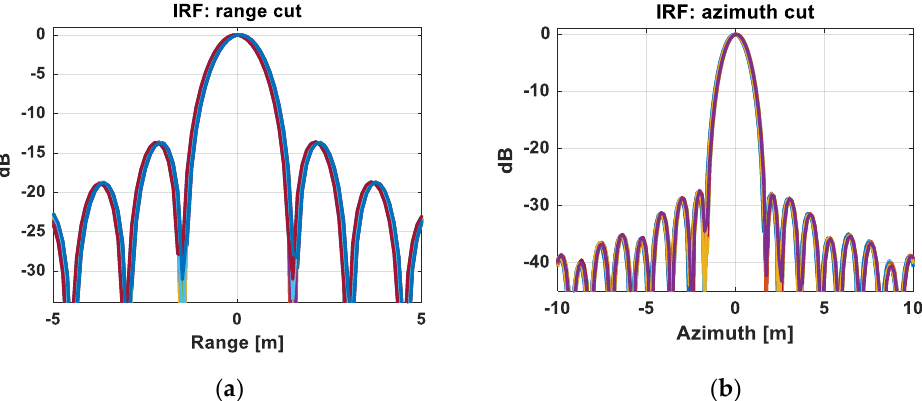
Figure 10. Zoom of the multichannel recombined focused impulse response of the nine point-targets in range ( a ) and azimuth ( b ). Each panel draws the superposition of nine almost identical plots.